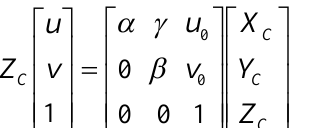
Fig. 1. Geometric model of linear structured light active vision sensing